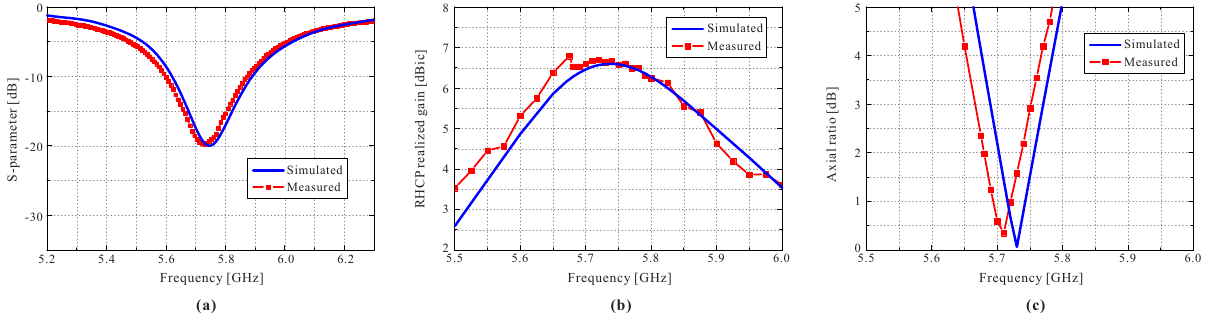
Figure 11. Simulated and measured results of the 5.8 GHz patch antenna: ( a ) reflection coefficients; ( b ) realized gain; ( c ) axial